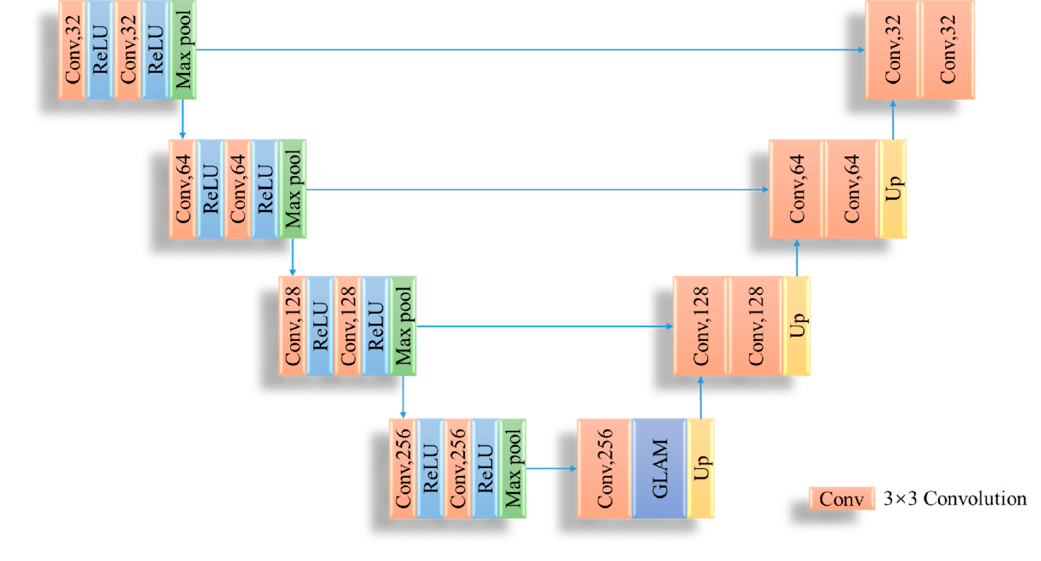
Figure 9. The structure of Enhance-Net.